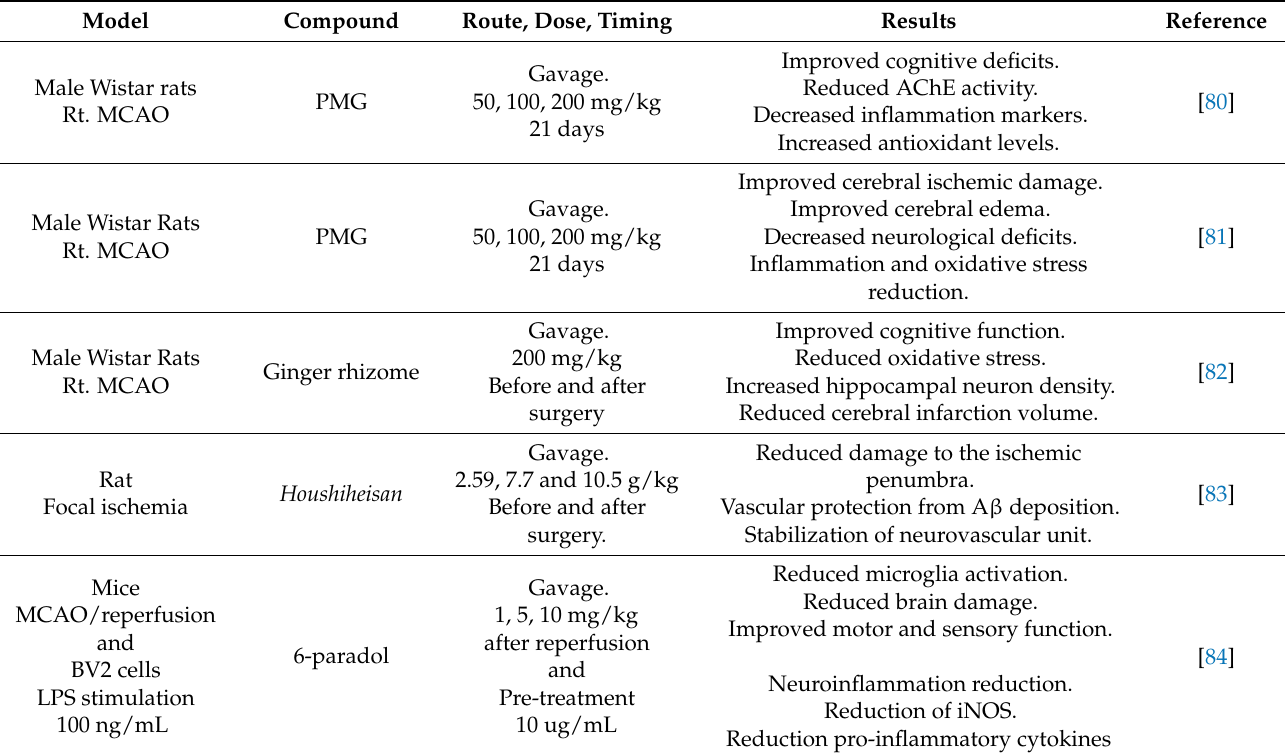
Table 2. Summary of reported studies on ginger effects in VD treatment of prevention.